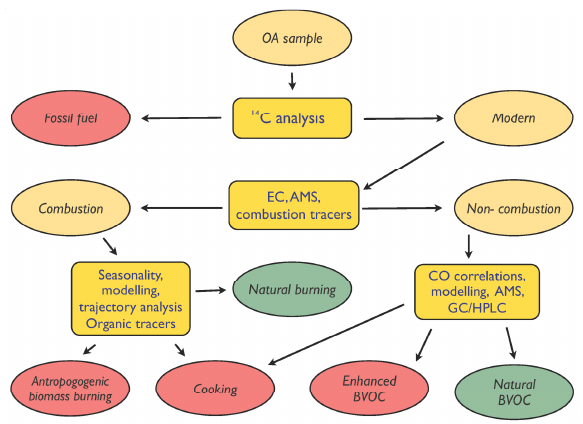
Fig. 2. A schematic depiction of the methods for source apportionment of the various fractions of ob- served organic aerosol. Enhanced SOA (eBSOA) results from an anthropogenic enhancement of SOA from BVOC, therfore we differentiate between natural BVOC and enhanced BVOC, even though the species and emission mechanisms are identical, as described in section 3. The rectangles describe some of the techniques and marker compounds used to seperate the different fractions. EC= elemental carbon, AMS= aerosol mass spectrometer, GC = gas chromatography, HPLC= high-pressure liquid chromatog- raphy.